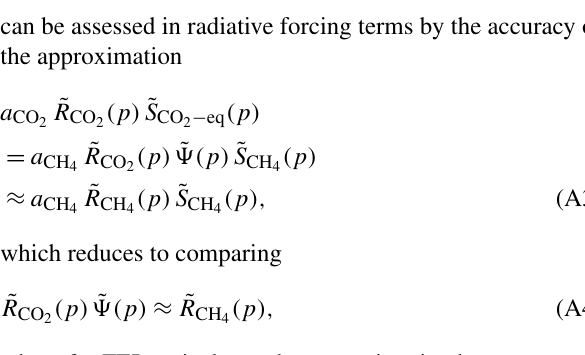
Figure A1 sets p = 2 iπf to evaluate the various cases con- sidered in the paper, as functions of frequency f in cycles per year. It shows the following